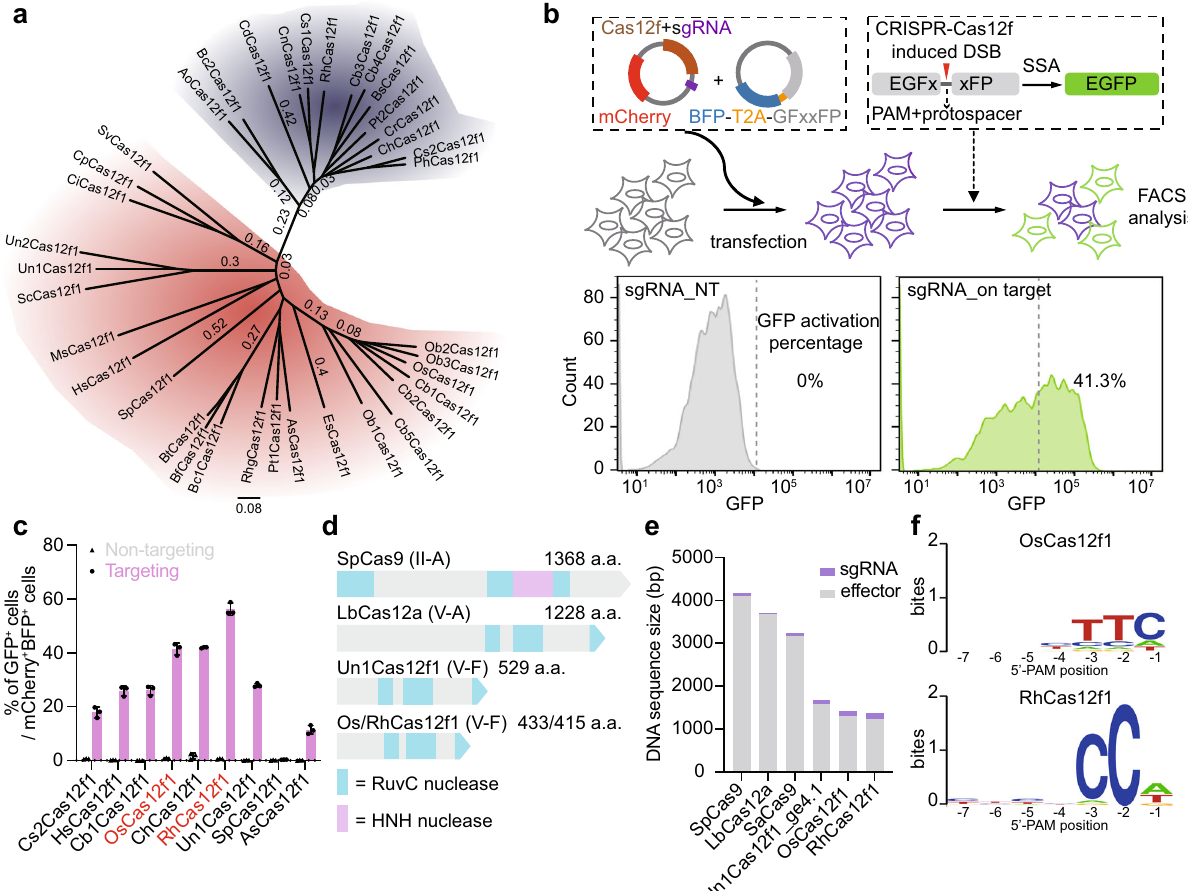
Fig. 1 | Identi fi cation and characterization of CRISPR loci and Cas protein of type V-F system. a Maximum-likelihood tree of identi fi ed Cas12f1 and previously reported Cas12f1. The evolutionary distance scale of 0.08 is shown. b Scheme of Cas12f1-induced EGFP activation in HEK293T cells. Transfection of plasmids expressing Cas12f1 and sgRNA activated EGFP. c Various Cas12f1 mediated EGFP activationef fi ciencydeterminedby fl owcytometry.Valuesanderrorbarsrepresent mean and s.d. ( n =3). Target sequence: CCATTACAGTAGGAGCATAC. NT means sgRNA with random spacer sequence. The two most ef fi cient Cas12f1s selected for